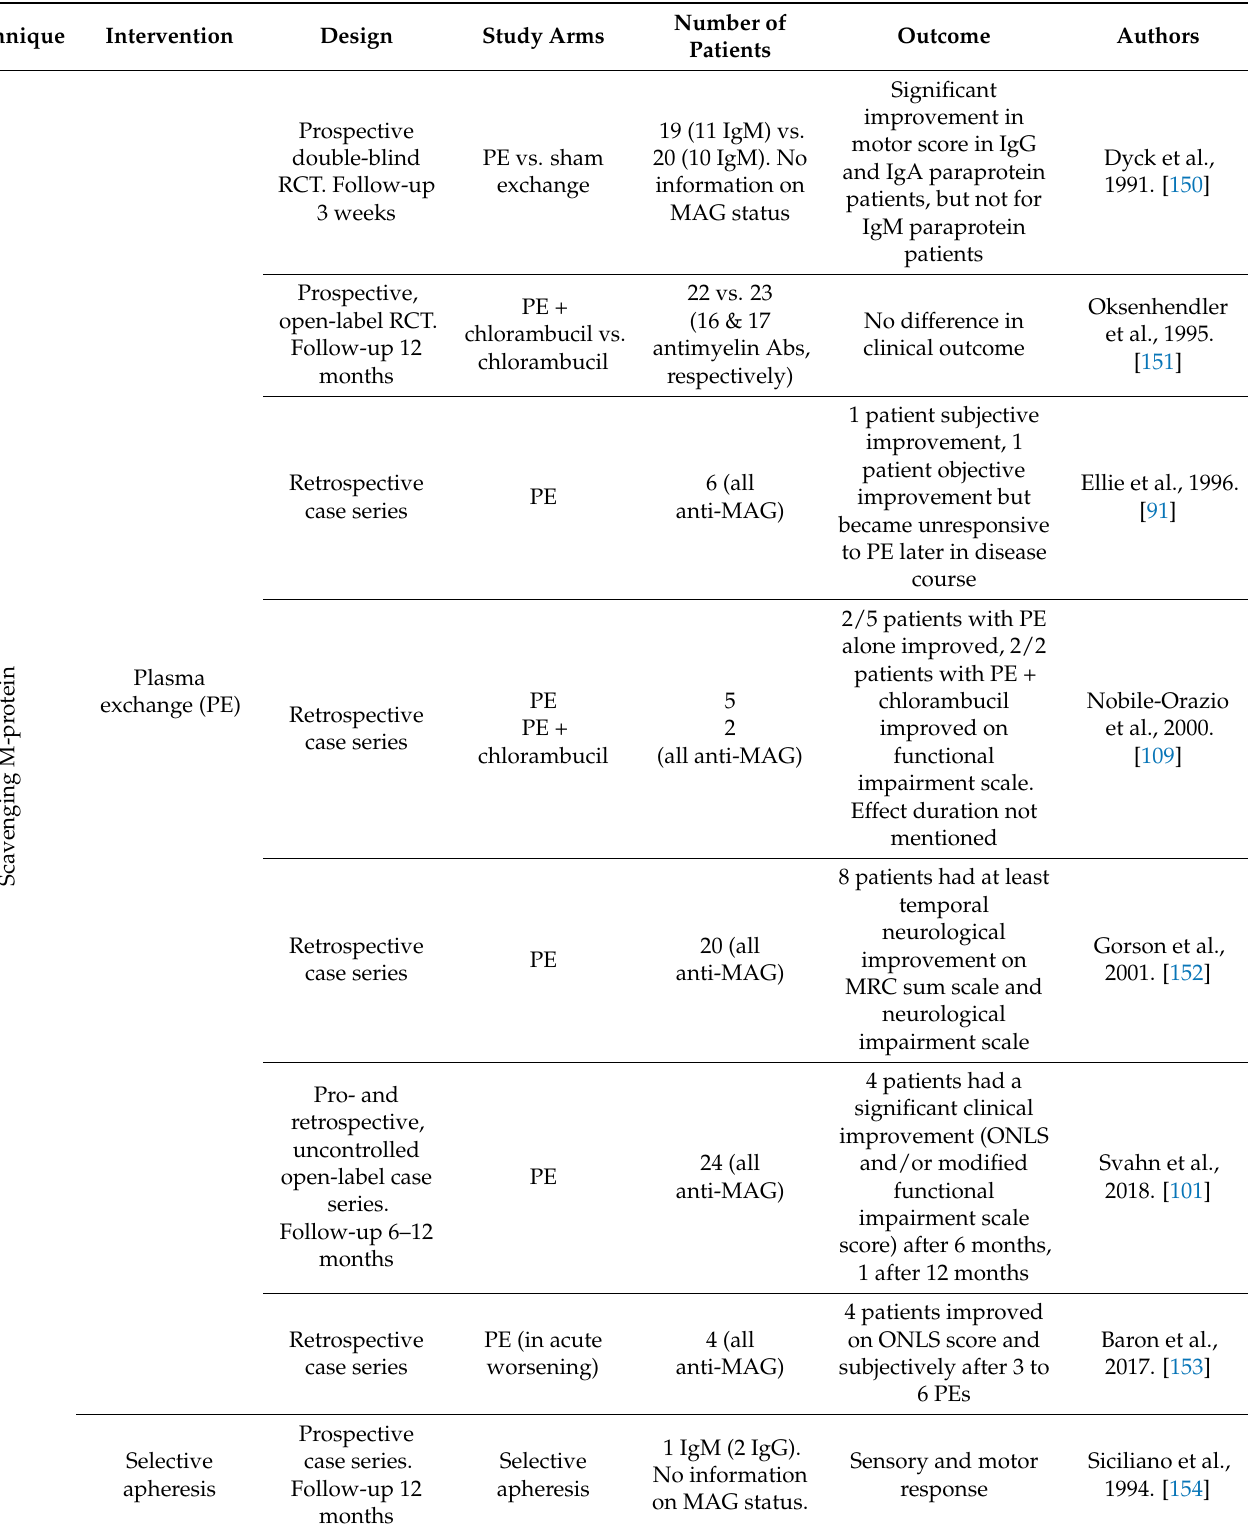
Table 2. Tried and current treatment options for IgM anti-MAG